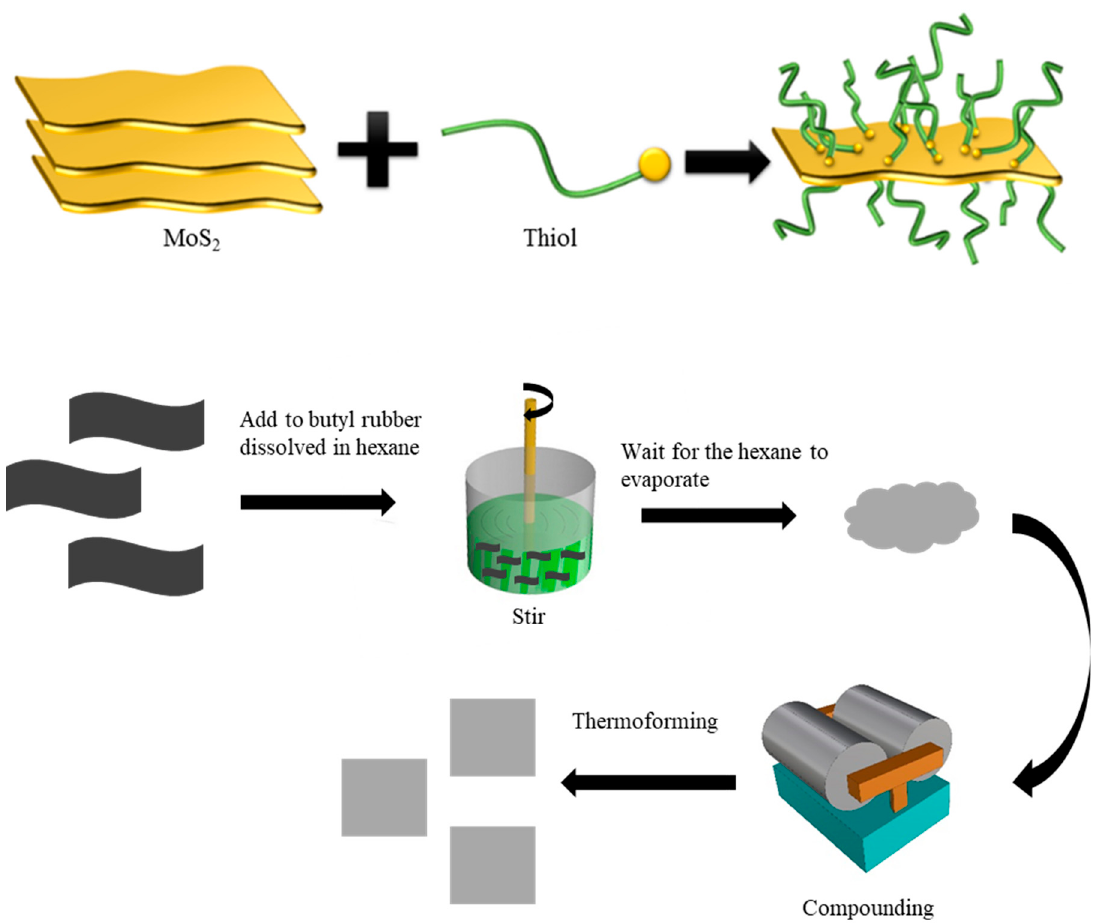
Scheme 1. Schematic illustration for exfoliation modification of MoS 2 and corresponding production of chlorobutyl rubber-based nanocomposites. of chlorobutyl rubber-based